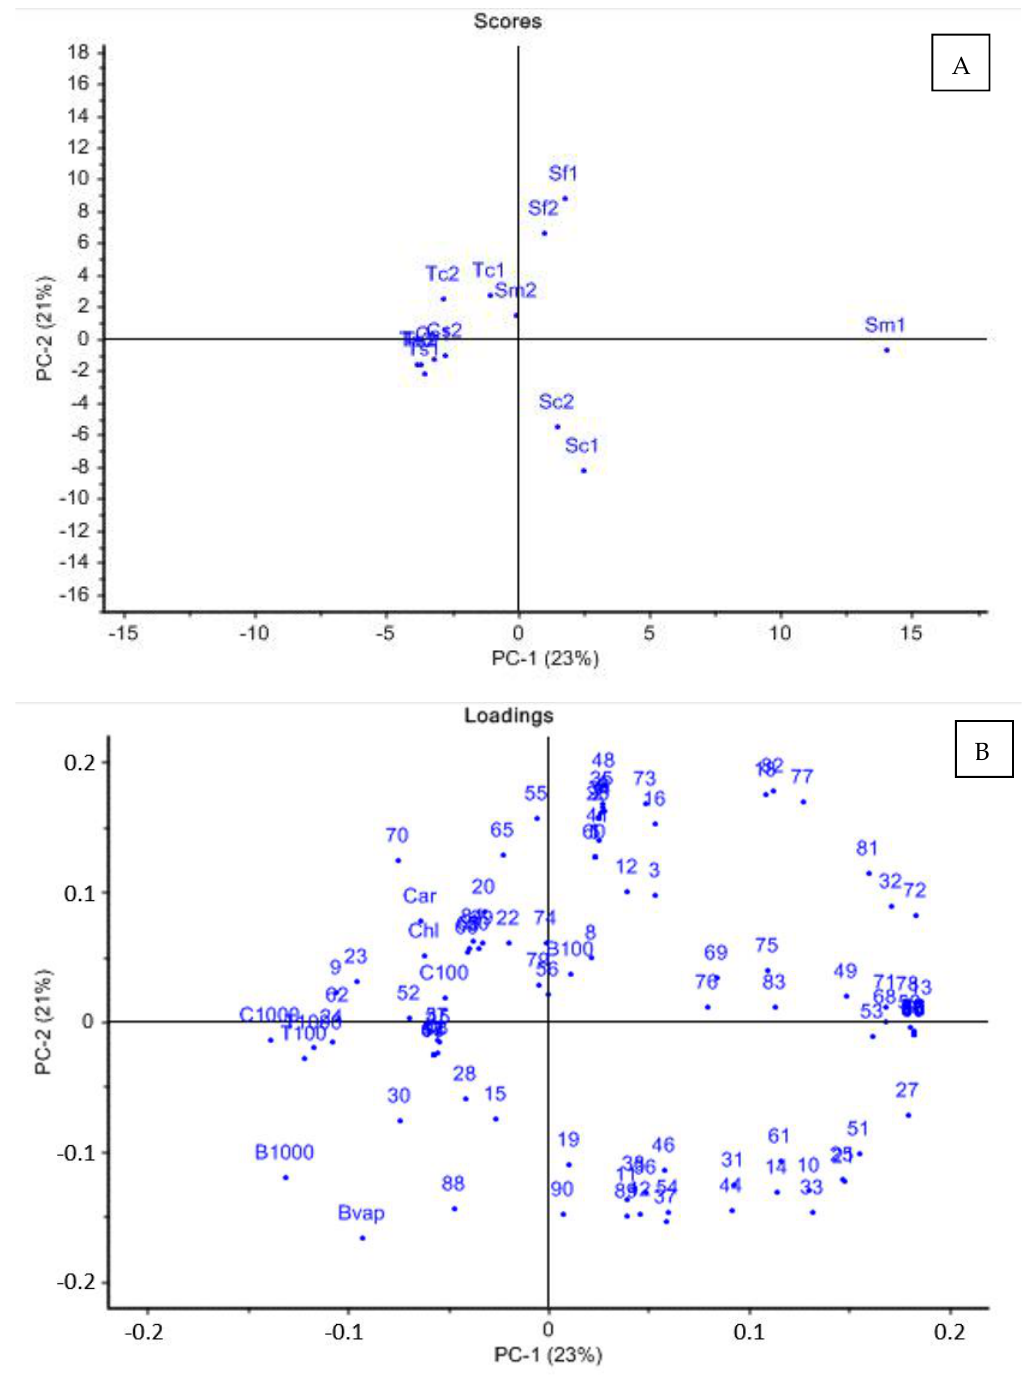
Figure 1. Principal component analysis (PCA) of data from the biological activity of EOs (expressed as % of inhibition) and their chemical composition. The score plot ( A ) indicates the sample distribution (EOs) based on the biological activity and metabolite composition. The loading plot ( B ) defines the correlation among variables: cress germination with EOs at 100 and 1000 ppm (C100 and C1000), tomato radicle growth with EOs at 100 and 1000 ppm (T100 and T1000), chlorophyll and carotenoid content (Chl and Car), broomrape germination with EOs at 100 ppm, 1000 ppm, and vapors (B100, B1000, and Bvap), concentration of the single compounds (numbered from 1 to 90, see Table 2) for each EO. Relationships between variables were further determined by Pearson correlation analysis (Table 7).